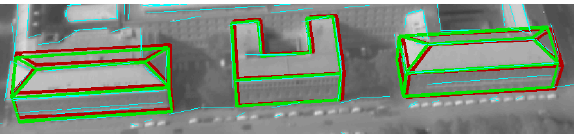
Figure 3: Projected 3D building model in frame 13209 before (red) and after (green) adjustment